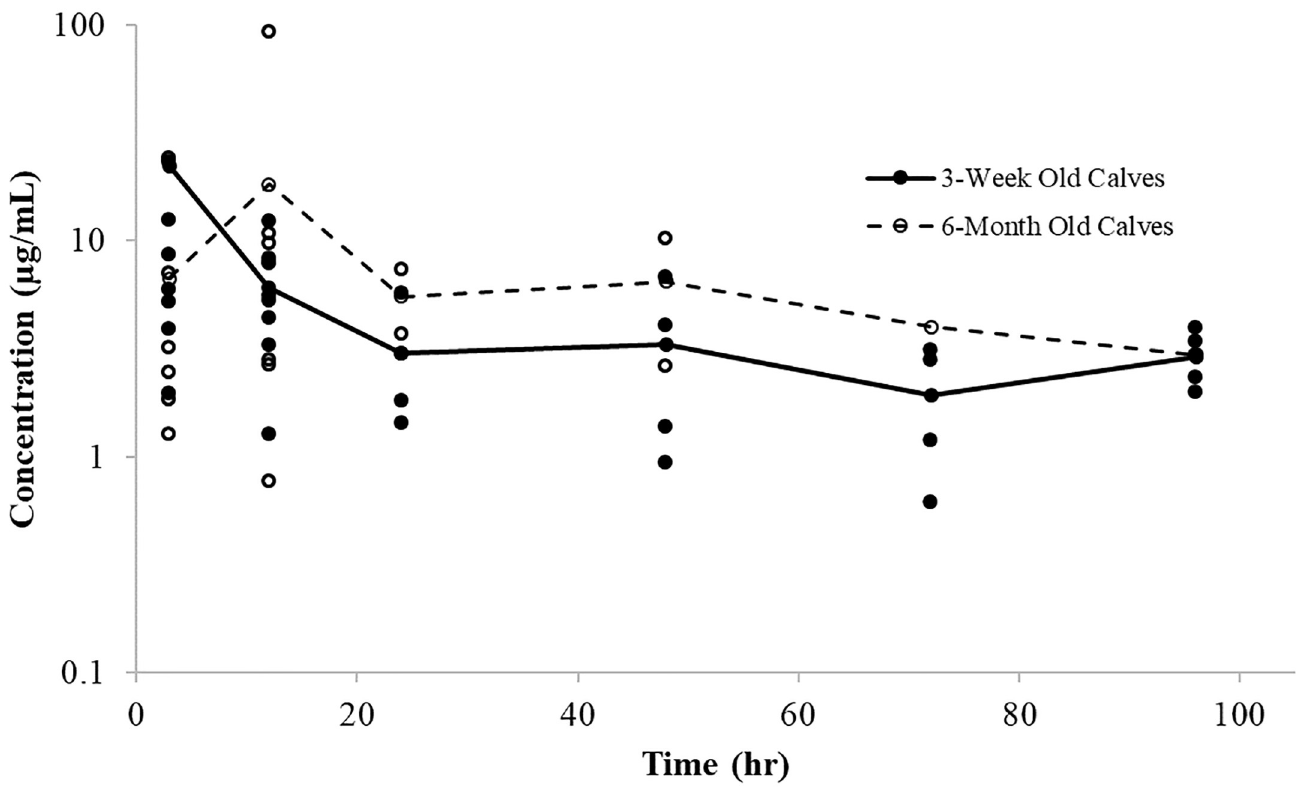
Fig 8. Individual PELF concentrations of tulathromycin. Lines represent average concentration over time for 3-week old calves (solid line) and 6-month old calves (dashed line).